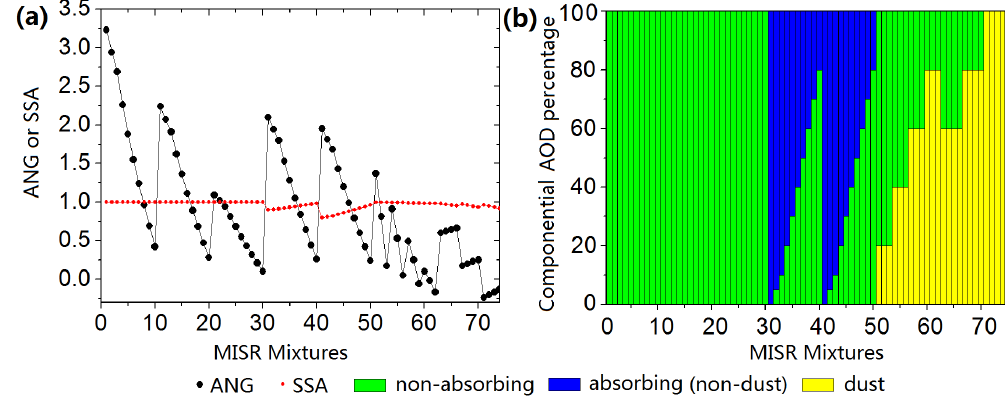
Figure 1. Graphical representation of the 74 aerosol mixtures in the MISR Version 22 standard product. Distributions of (a) Ångström exponent and SSA at 558nm; (b) AOD percentages, by component categories, for each